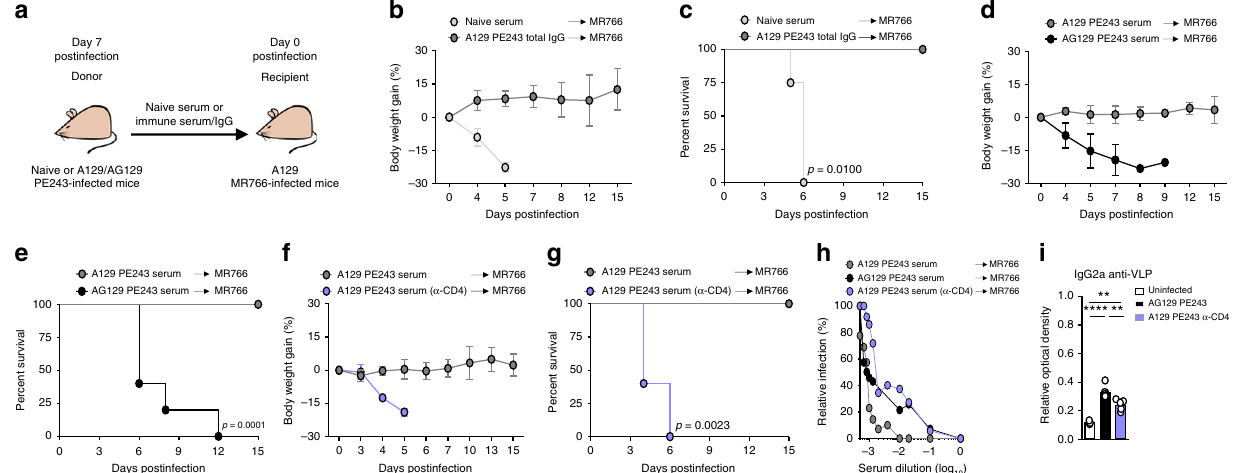
Fig. 6 Serum of ZIKV PE243-infected A129 mice protects against ZIKV MR766 infection. a Schematic representation of passive serum